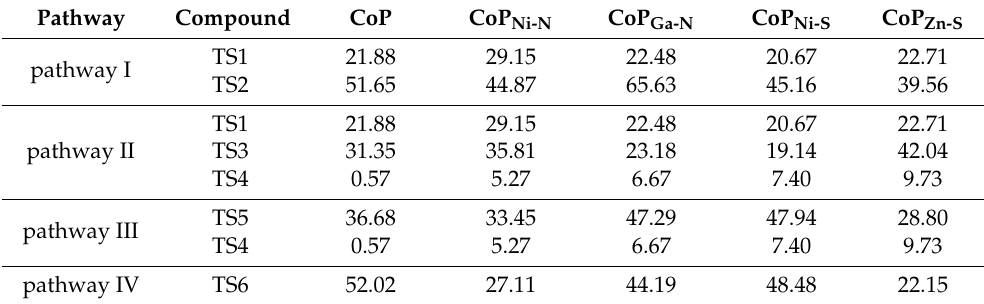
Table 3. The reaction pathway activation energies of five catalysts in pathway I–IV (kcal/mol). Pathway Compound CoP CoP Ni-N CoP Ga-N pathway